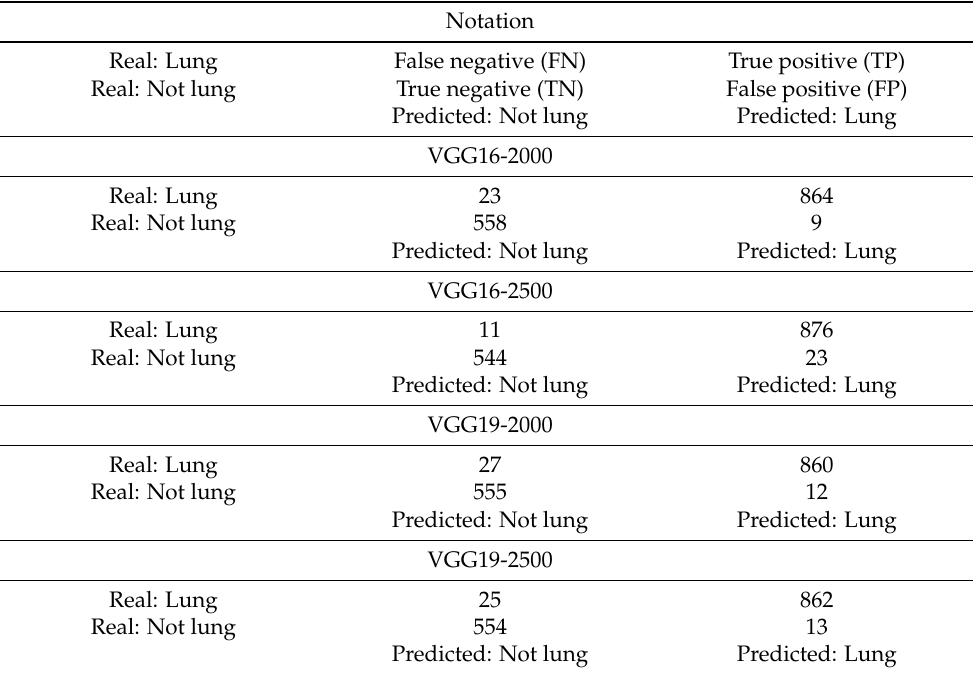
Table 3. Confusion matrices for the validation set.